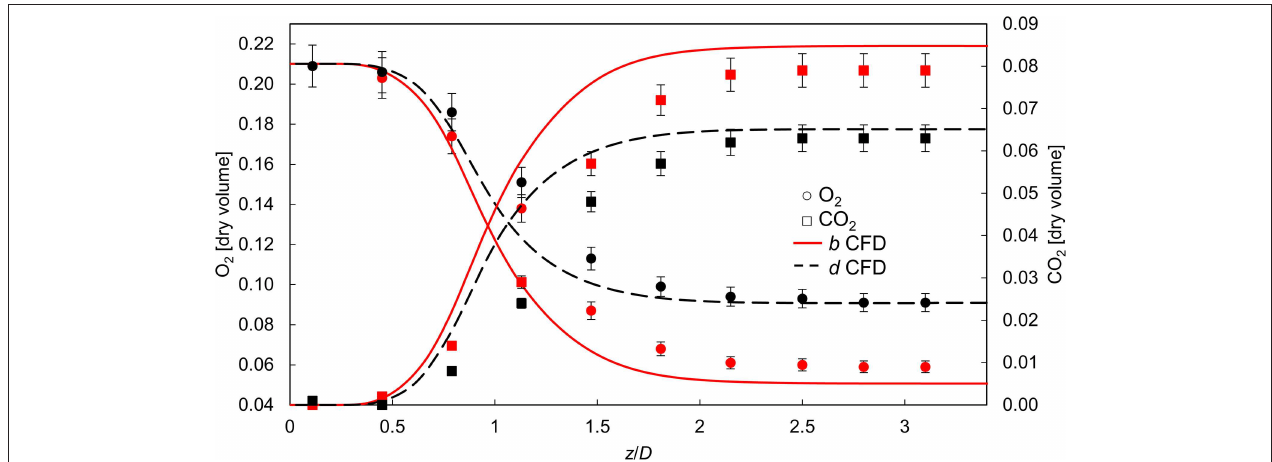
FIGURE 6 | Experimental and CFD results along the centerline of the combustor for O 2 and CO 2 concentrations for conditions b ( φ ∼= 0.77) and d ( φ ∼= 0.59).